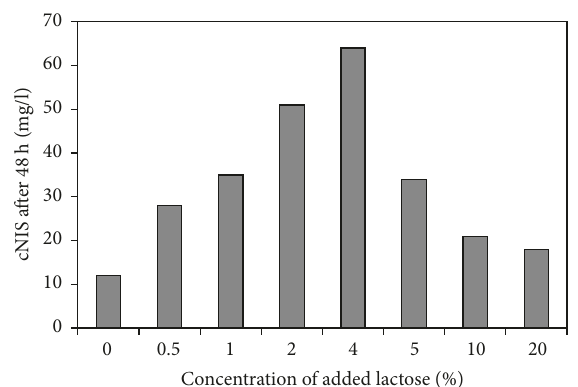
Figure 1: Effect of fermentation media fortification with lactose on nisin production after 48 hours of fermentation. Data points are average values of three independent analyses by RP-HPLC.Standard errors were less than